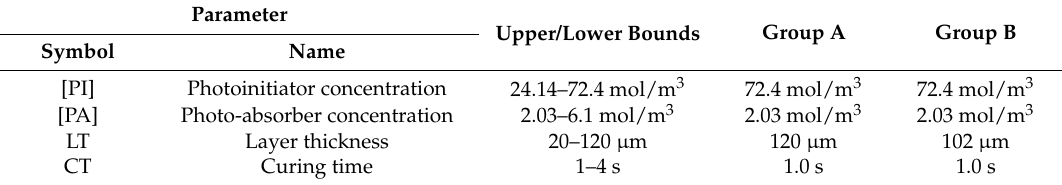
Table 7. List of optimizing parameters.